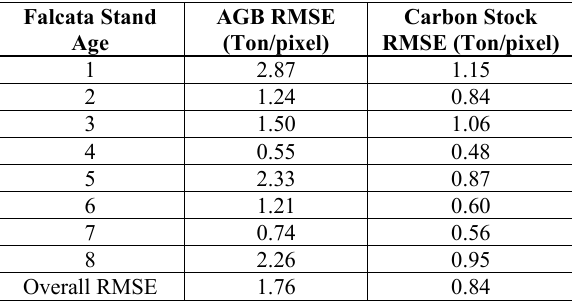
Table 5. RMSEs of AGB and Carbon Stock per Stand